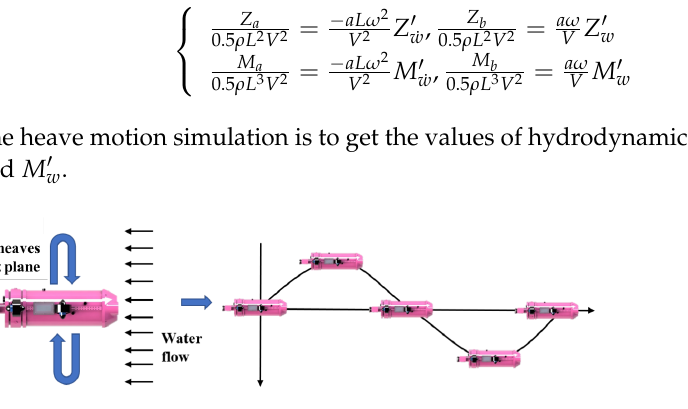
Figure 10. Schematic diagram of heave motion of the Shark-AUV.